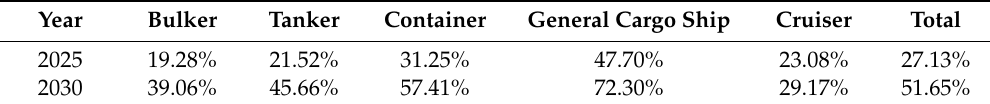
Table 3. Conversion Ratio to LNG Fueled Vessel by